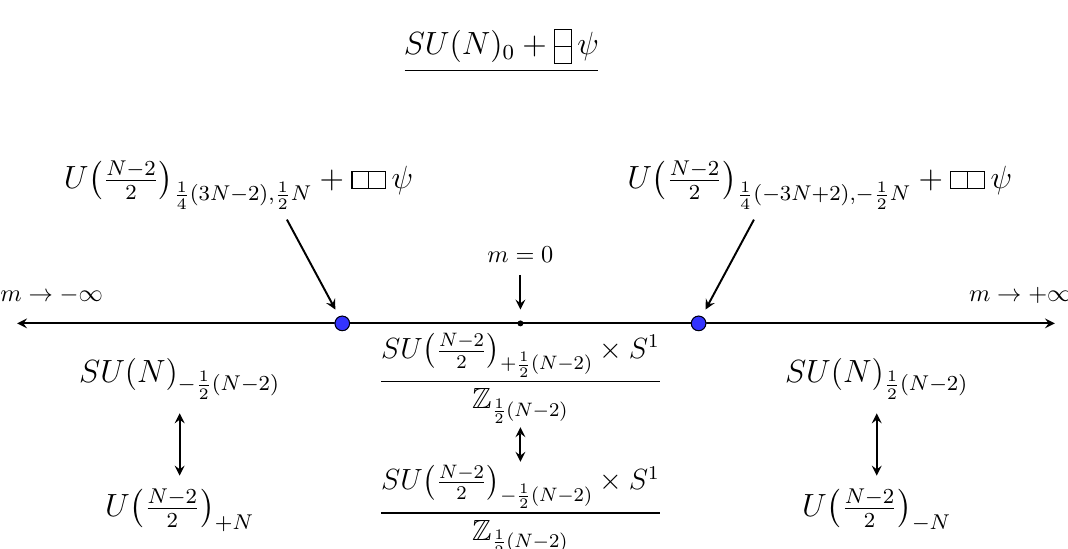
Figure 6 . Phase diagram of SU( N ) gauge theory with a antisymmetric fermion for k = 0. The circle S 1 represents the gapless sigma model with S 1 target space. Each phase transition has a dual gauge theory description, which appears with an arrow pointing to the phase transition. The mass deformations are related by m = (cid:0) m ^ and m = (cid:0) m ~